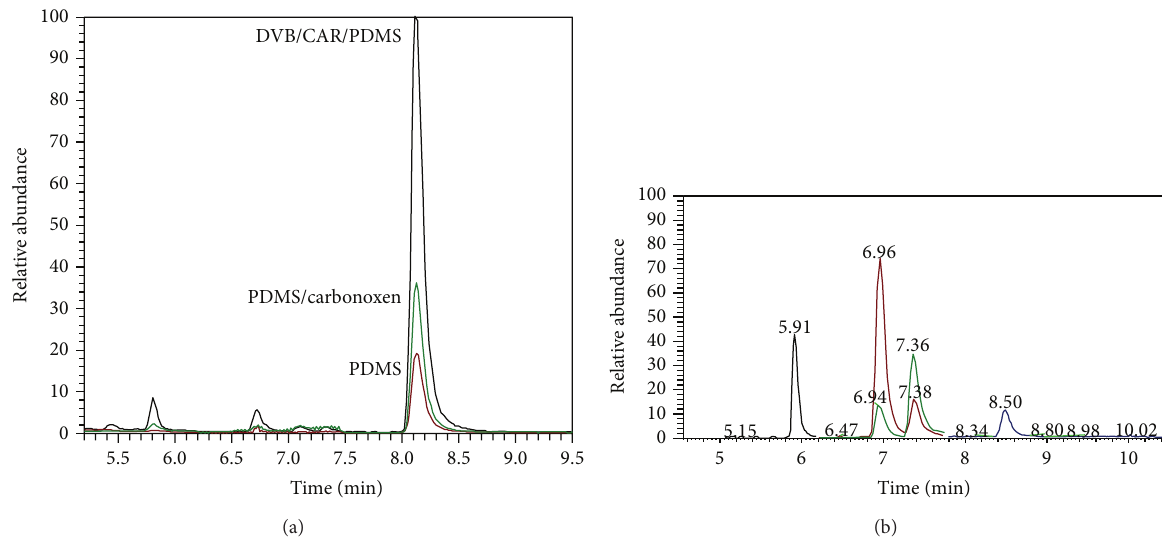
Figure 4: Internal standard (halothane) peaks obtained with three different types of fibers. The most efficient extraction has been obtained through DVB/CAR/PDMS fiber.